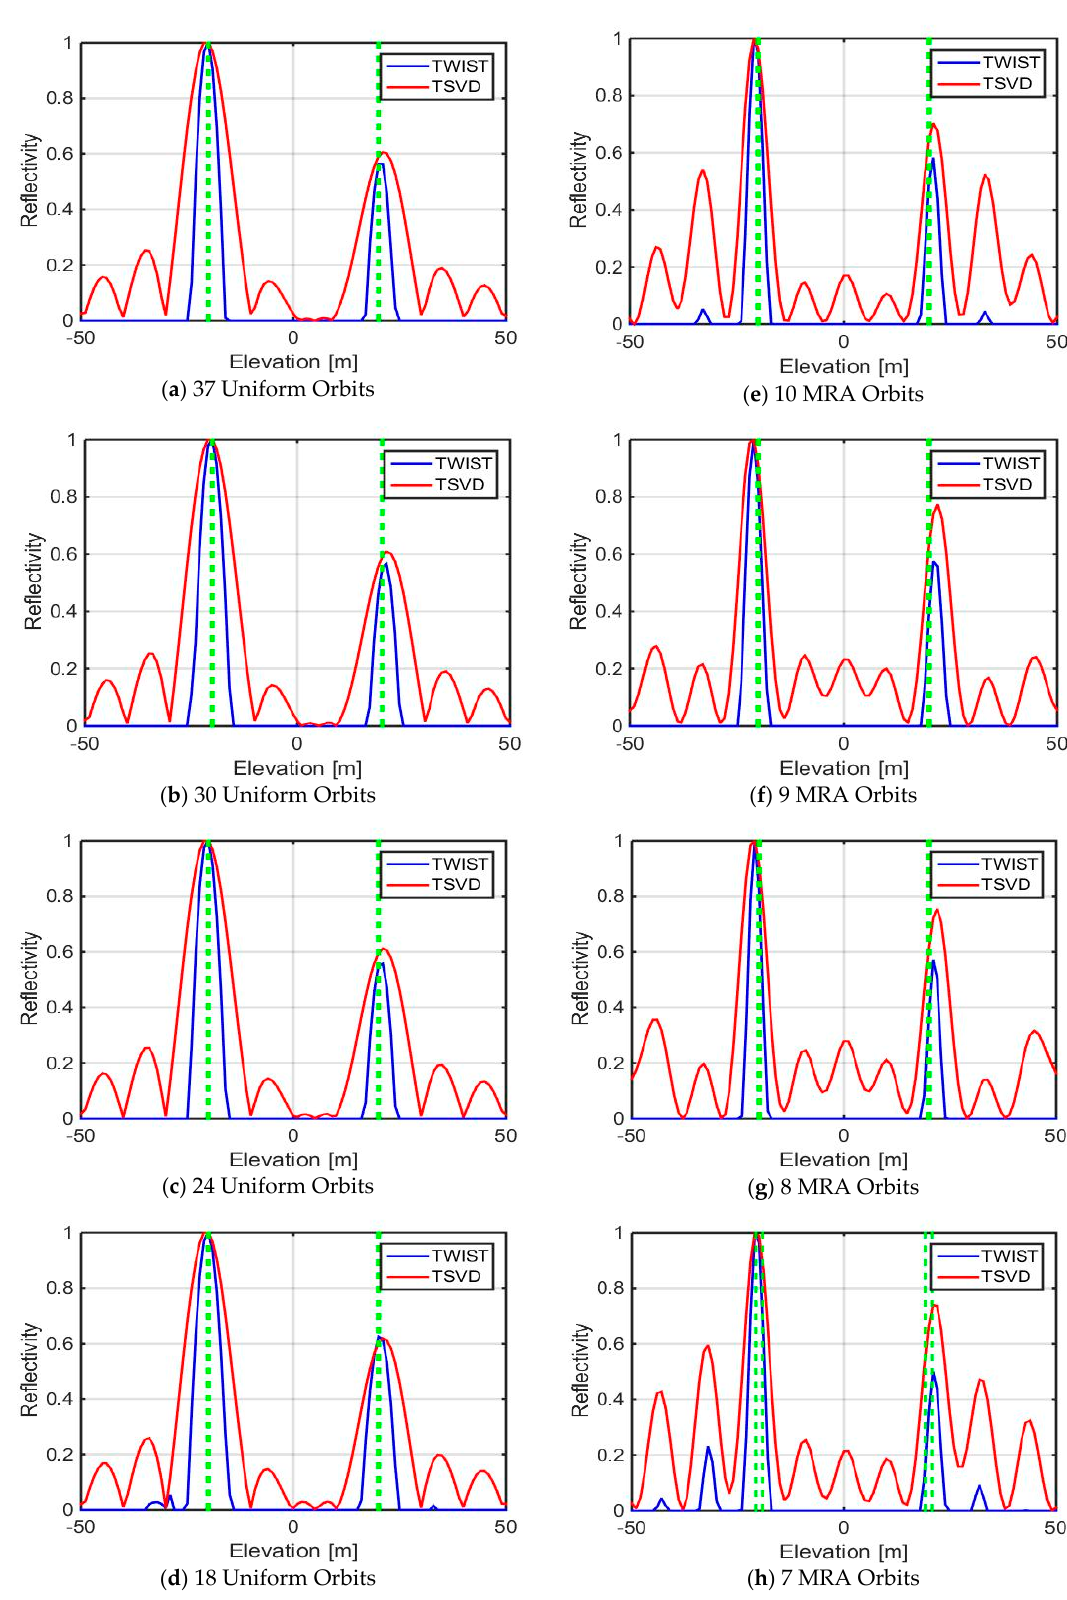
Figure 4. Tomographic performance of TWIST and TSVD on double scatters using uniform orbits ( a – d ) and MRA orbits ( e – h ) in noise free case.